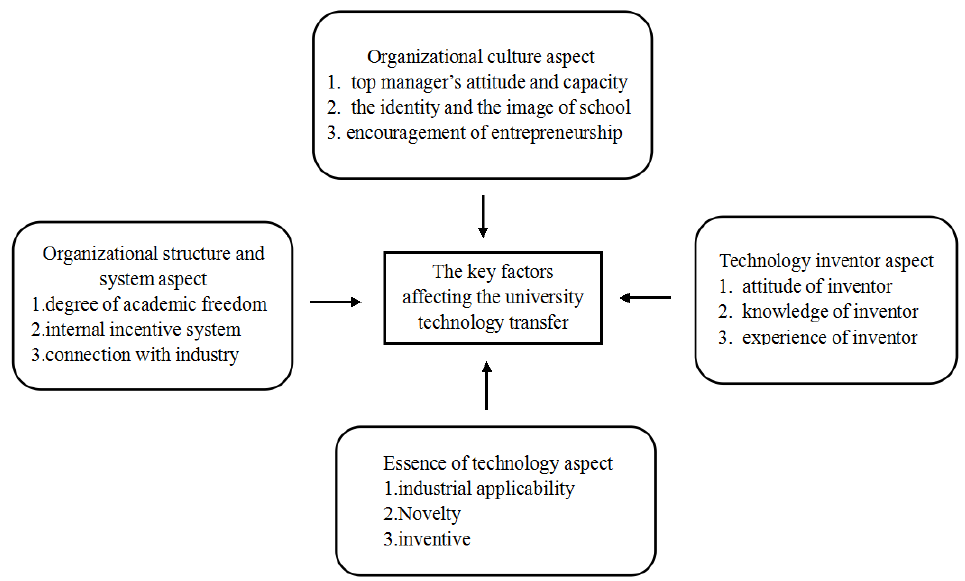
Figure 1. Research